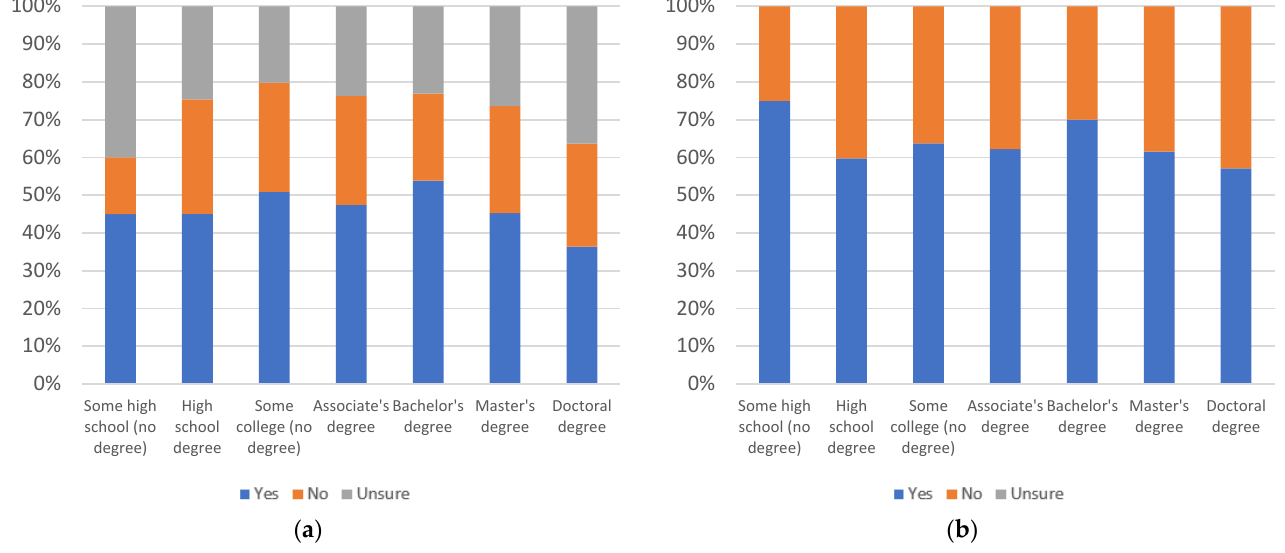
Figure 95. Label others’ use, by education level: ( a ) with uncertain respondents (left) and ( b ) without uncertain respondents (right).